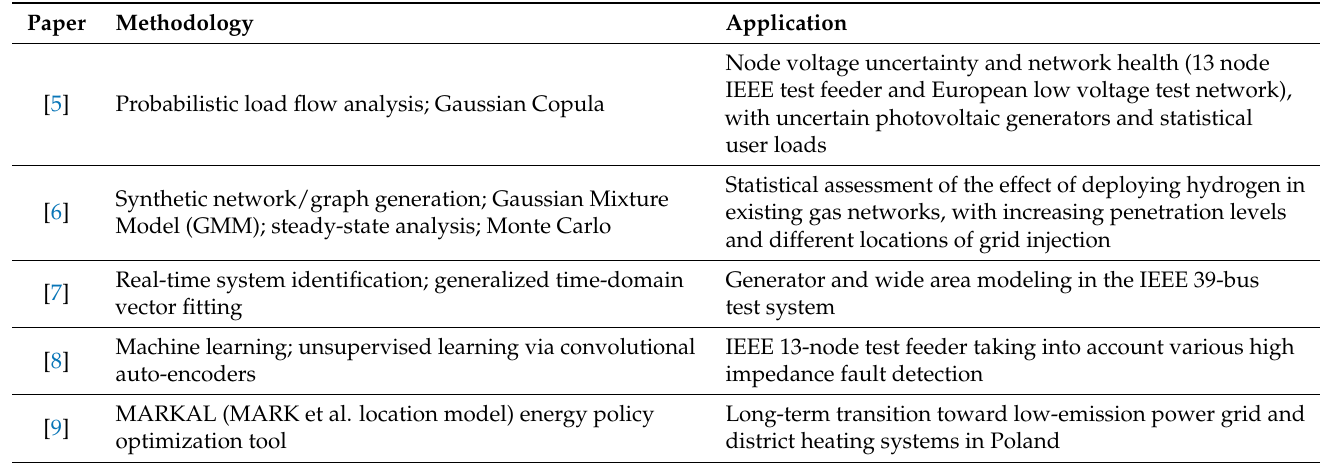
Table 1. Summary of the different contributions published in the Special Issue in terms of both methodology and